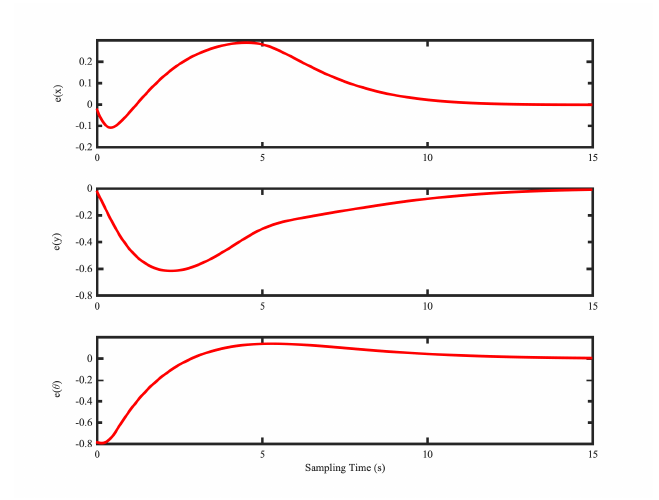
Figure 6. The biomimetic spherical robot trajectory tracking on a xoy plane-Case I.